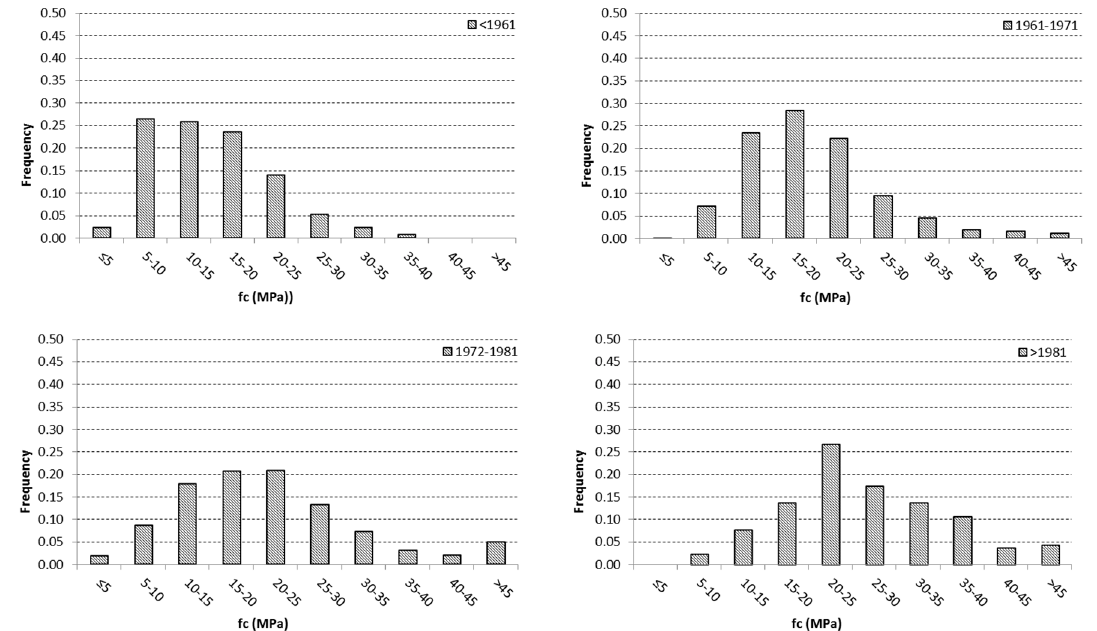
Figure 2. Distribution of the f c values in the construction periods under consideration.